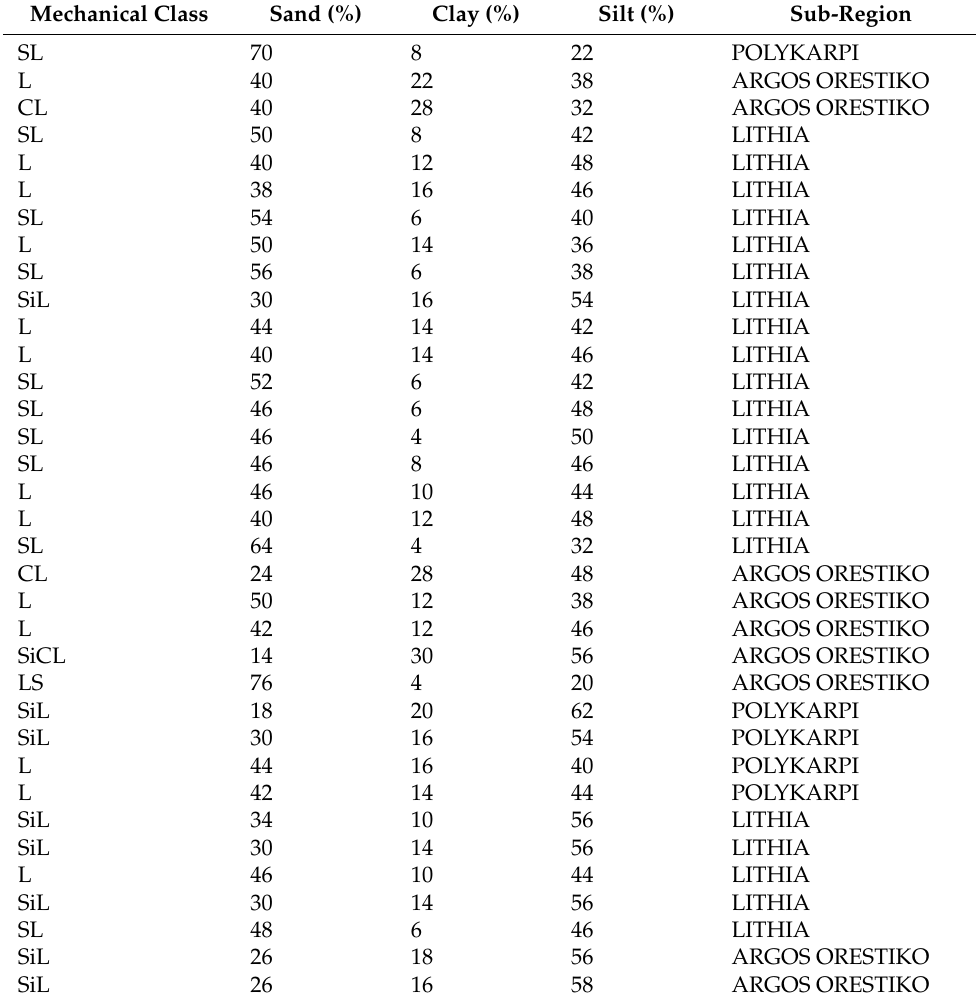
Table A2. Soil texture measurements of Kastoria